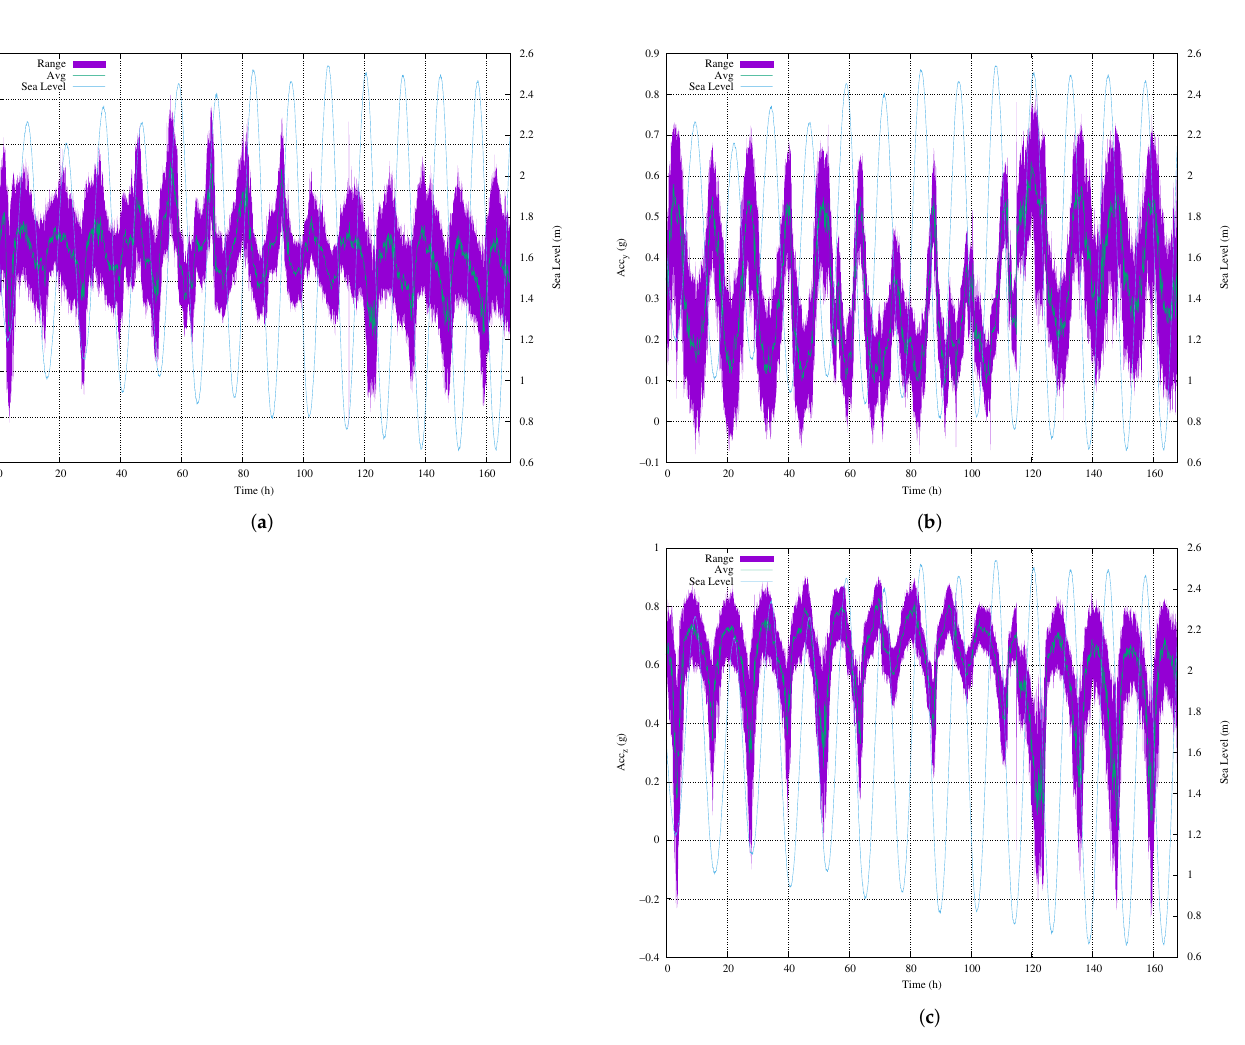
Figure 12. The time representations of the acquired data for the full week of measurements: ( a ) ACC X ; ( b ) ACC Y ; ( c ) ACC Z